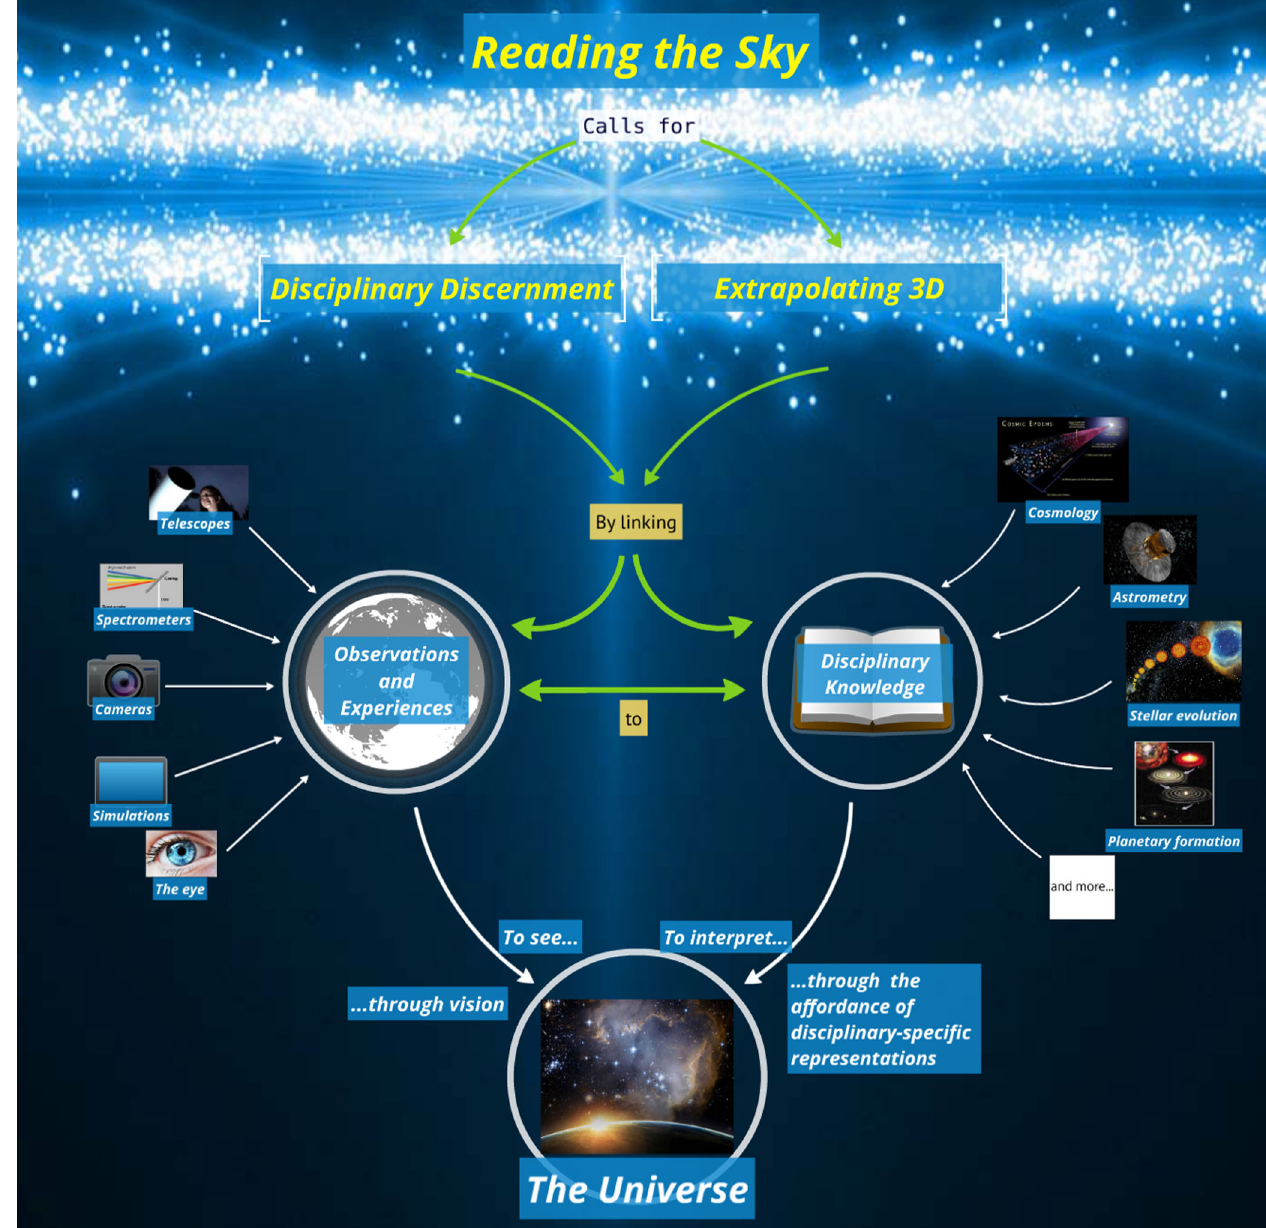
FIG. 1. A graphical representation of how reading the sky is related to disciplinary discernment and extrapolating three dimensionality, by linking observations and experiences to disciplinary